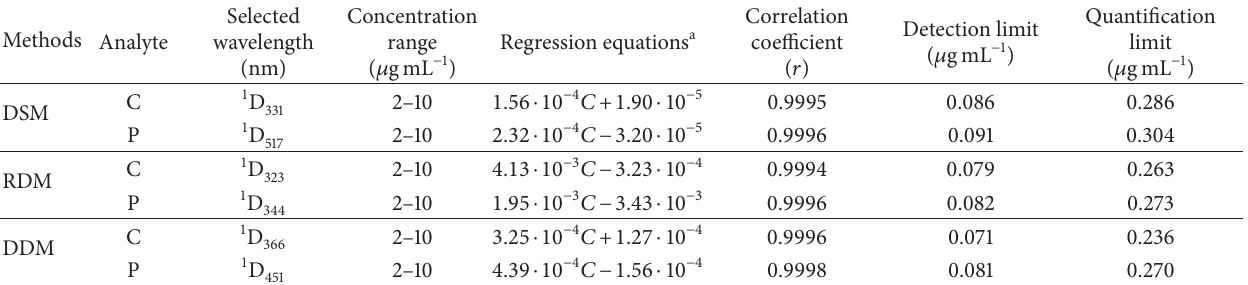
Table 2: Statistical parameters of the simultaneous determination of Carmoisine and Ponceau 4R by DSM, RDM, and DDM. Methods